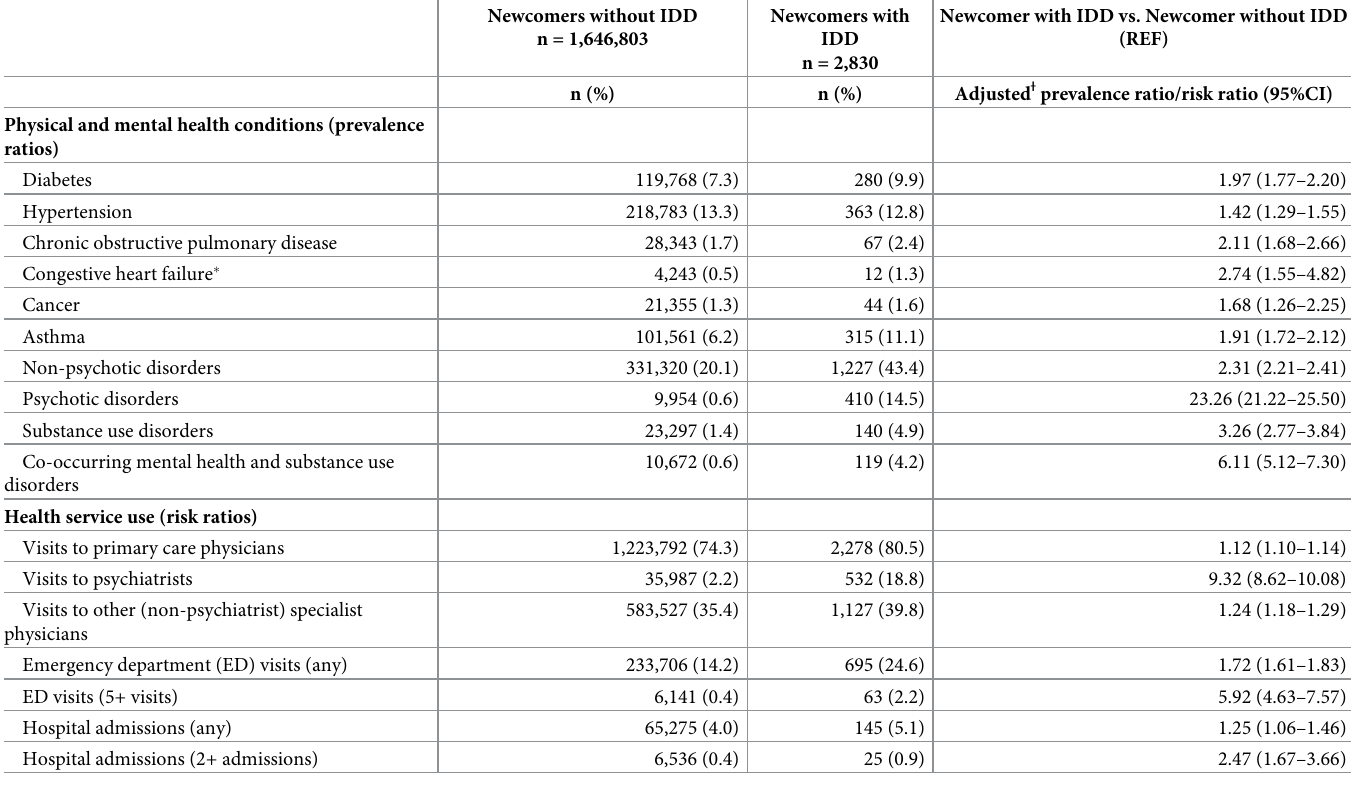
Table 3. Adjusted prevalence/risk ratios for physical/mental health profiles and health service use of newcomers with and without intellectual and developmental disabilities (IDD), for adults aged 19–65 in Ontario, FY